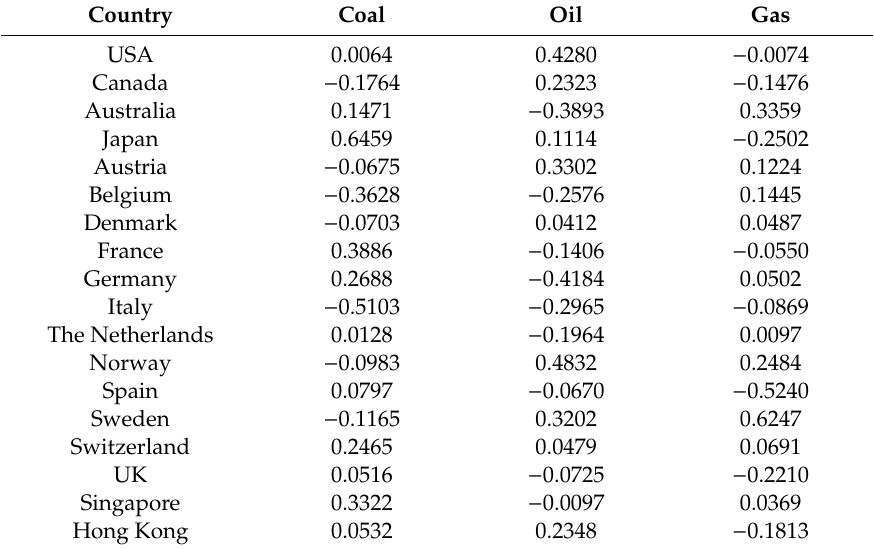
Table 23. Correlations from the last subsample